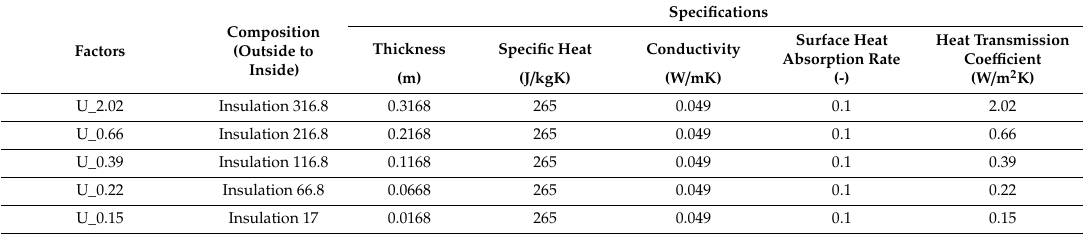
Table 7. Heat transmission coe ffi cient of wall.